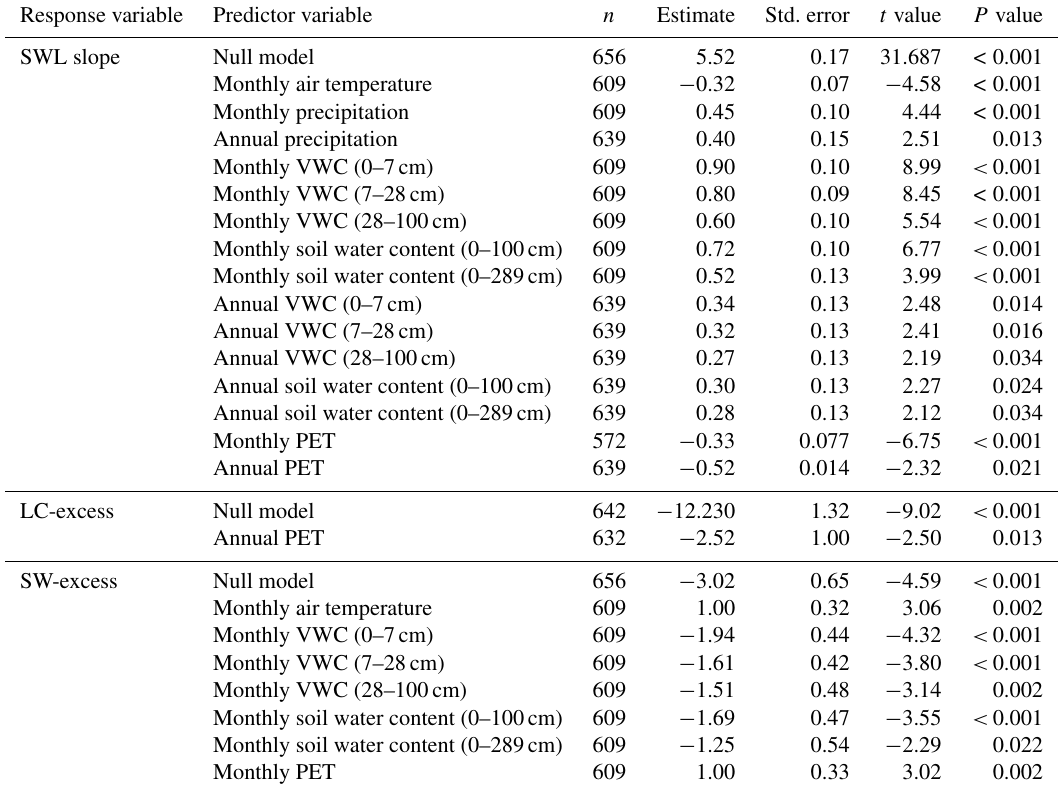
Table 2. Results ( t and P ), sample size ( n ), and estimated slope (except for the null model, where “estimate” is the intercept) and standard error, according to the linear mixed models (including the null models without any predictor variables) to assess the effects of temperature, soil volumetric water content (VWC), and potential evapotranspiration (PET) on the slope of the soil water line (SWL slope), line-conditioned excess (LC-excess), and soil water excess (SW-excess). All parameter estimates have been standardised. Only models with significant results are